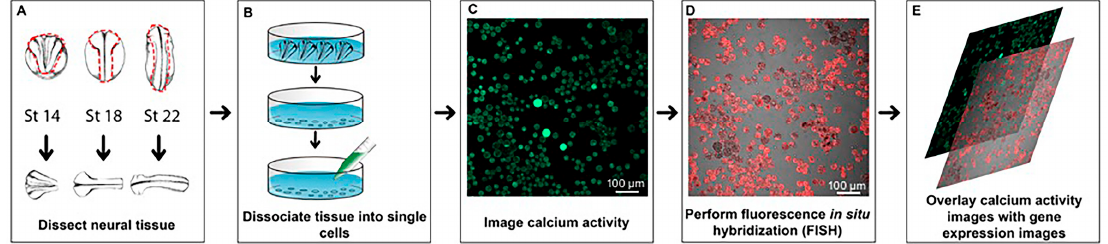
Figure 1. Overview schematic showing dissociation of neural tissue, calcium imaging and subsequent molecular phenotype identification of individual cells. ( A ) Dissection of embryonic neural tissue at neural plate (Stage 14), neural tube (Stage 18) and early tailbud stage (Stage 22). ( B ) Dissociation of explant in calcium and magnesium free solution followed by Fluo-4 AM treatment. ( C ) A representative fluorescence still image acquired using Nikon A1R T i Laser Scanning Confocal Microscope. ( D ) Identification of molecular phenotype using fluorescence in situ hybridization assay. ( E ) Overlay of calcium activity images with gene expression.